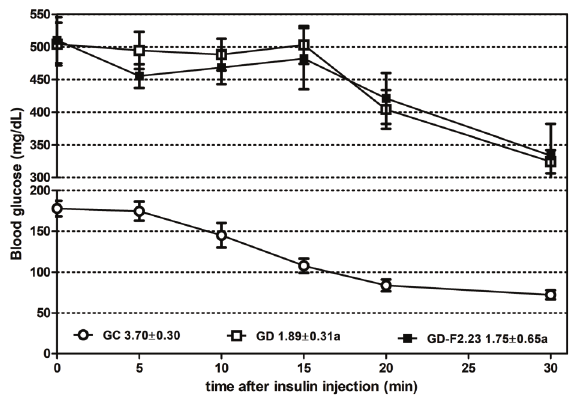
Figure 3. Insulin tolerance test and blood glucose decay index of mice from groups GC, GD, and GD-F2.23. GC: control group; GD: diabetic animals; GD-F2.23: diabetic animals that were injected with hydrogel + 2.23 m g/mL phthalocyanine. Data are reported as means ± SD; n=4 – 6/group. a: P o 0.05 vs GC, one-way ANOVA/ Tukey.